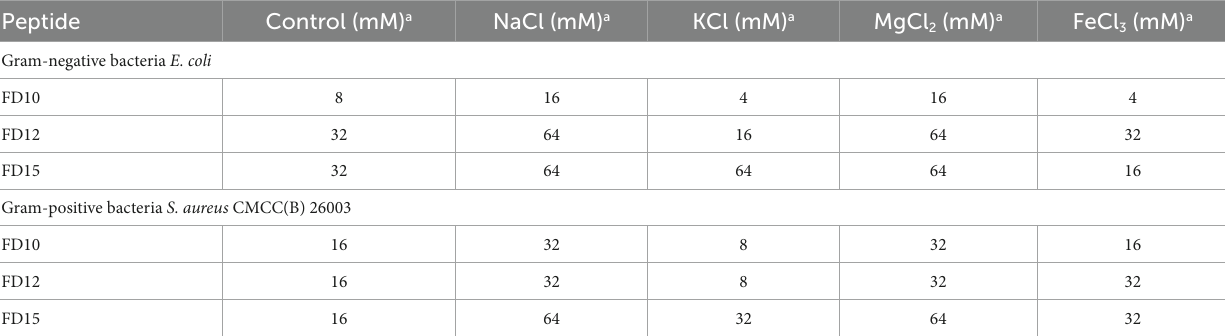
TABLE 5 MIC of peptides in the presence of physiological salts.